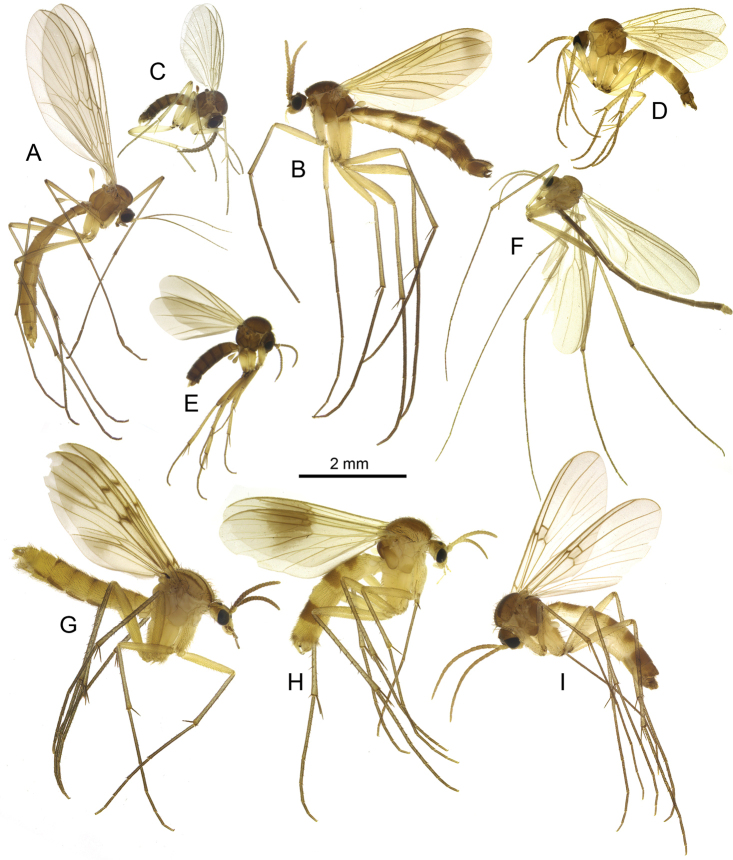
Habitus of Georgian fungus gnats of the families Bolitophilidae (A), Keroplatidae (B) and Mycetophilidae (C–I) ABolitophila (Bolitophila) basicornis (Mayer, 1951) BOrfelia
georgica Kurina & Jürgenstein, 2013 CAcnemia
nitidicollis (Meigen, 1818) DMonoclona
rufilatera (Walker, 1837) EAzana (Azana) anomala (Staeger, 1840) FPhthinia
hyrcanica Zaitzev, 1984 GNeoempheria
striata (Meigen, 1818) HNeoempheria
brevilineata Okada, 1939 IMycomya (Mycomya) marginata (Meigen, 1818).